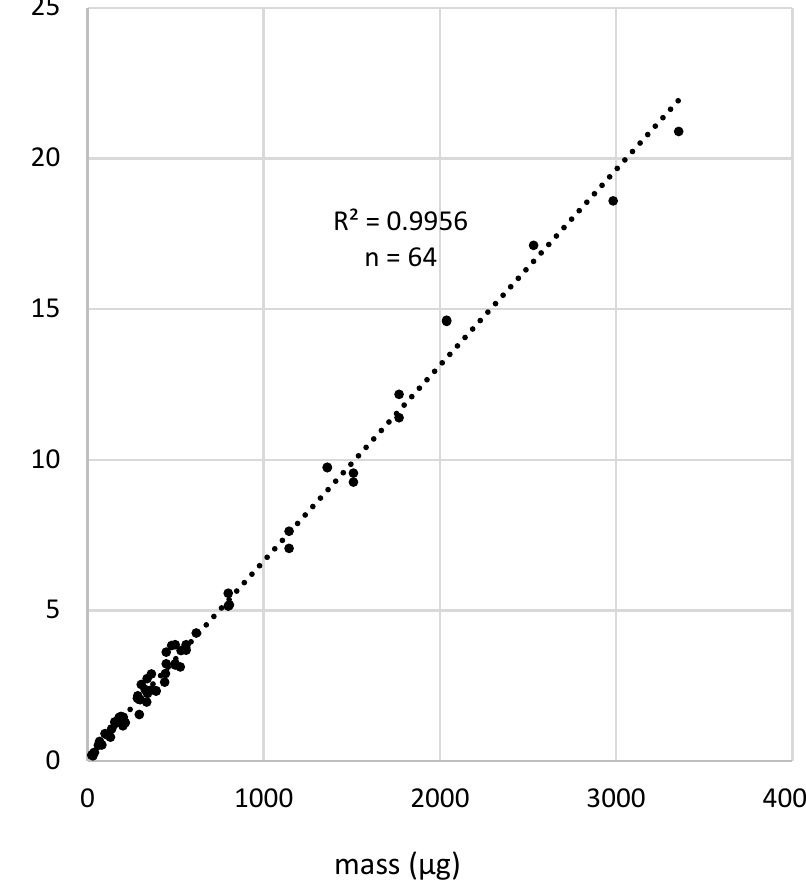
Figure 1. Calibration curve for determining quartz mass in lab-generated respirable dust samples collected in 2-piece cassettes from a small enclosure with high dust concentration. The curve was created by correlating the FTIR-derived integrated peak area for quartz to Min-U-Sil ® 5 mass ( µ g) on the filter (determined gravimetrically).